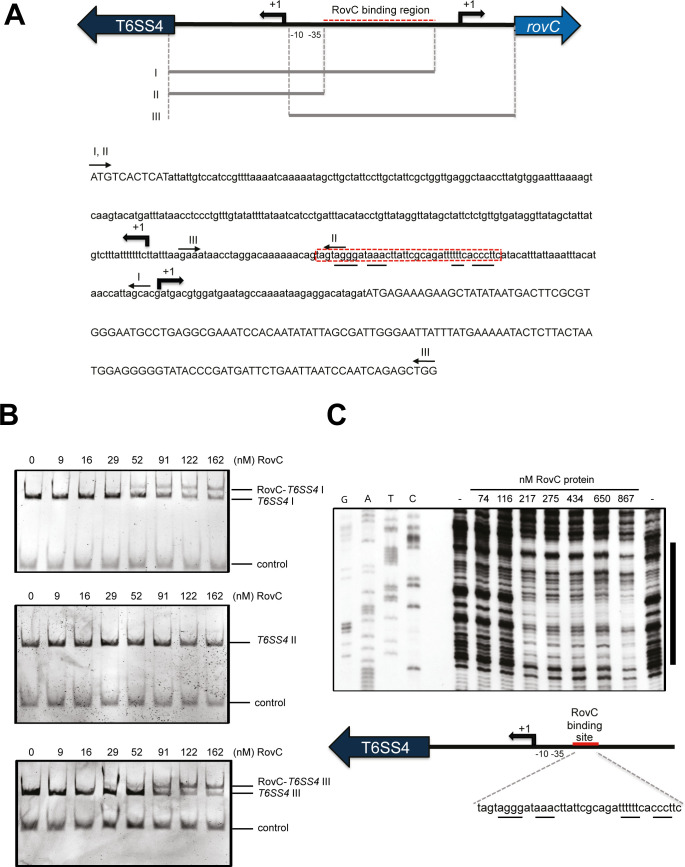
RovC specifically binds to the T6SS4 promoter region.(A) Schematic representation of the T6SS4 and rovC upstream region. The fragments harboring varying lengths of the upstream region used for the RovC-DNA binding analysis are shown below the fragment and are labeled with roman numbers (I to III). The RovC binding region is marked in red (dashed line) and the transcriptional start sites of the T6SS4 operon and the rovC gene are indicated with +1 and a broken arrow. The -10 and -35 regions of the T6SS4 promoter are indicated. Primers for amplification of the fragments are indicated by arrows. (B) DNA binding analysis with purified RovC protein. 130 fmol of DNA were incubated with increasing amounts of hexameric RovC protein (0–162 nM) for 30 min at room temperature. A csiD DNA fragment from E. coli was used as negative control. (C) DNase I footprinting assay to identify the RovC binding site using the rovC+ plasmid pSSE11 as template. The protected region is indicated on the right and is indicated in a schematic representation as a red line. RovC binds to the T6SS4 promoter in a region approximately -70 to -32 bp upstream of the T6SS4 transcriptional start site (+1). T6SS4 DNA and a sequencing reaction were amplified with a DIG-labeled primer. T6SS4 DNA was incubated with increasing concentrations of RovC protein (0–900 nM) for 30 min at room temperature and was subsequently digested with an appropriate concentration of DNase I for 30 sec. The DNA-protein samples and the sequencing reaction were separated on a 6% urea gel, transferred onto a nylon membrane and visualized with a digoxigenin antibody.